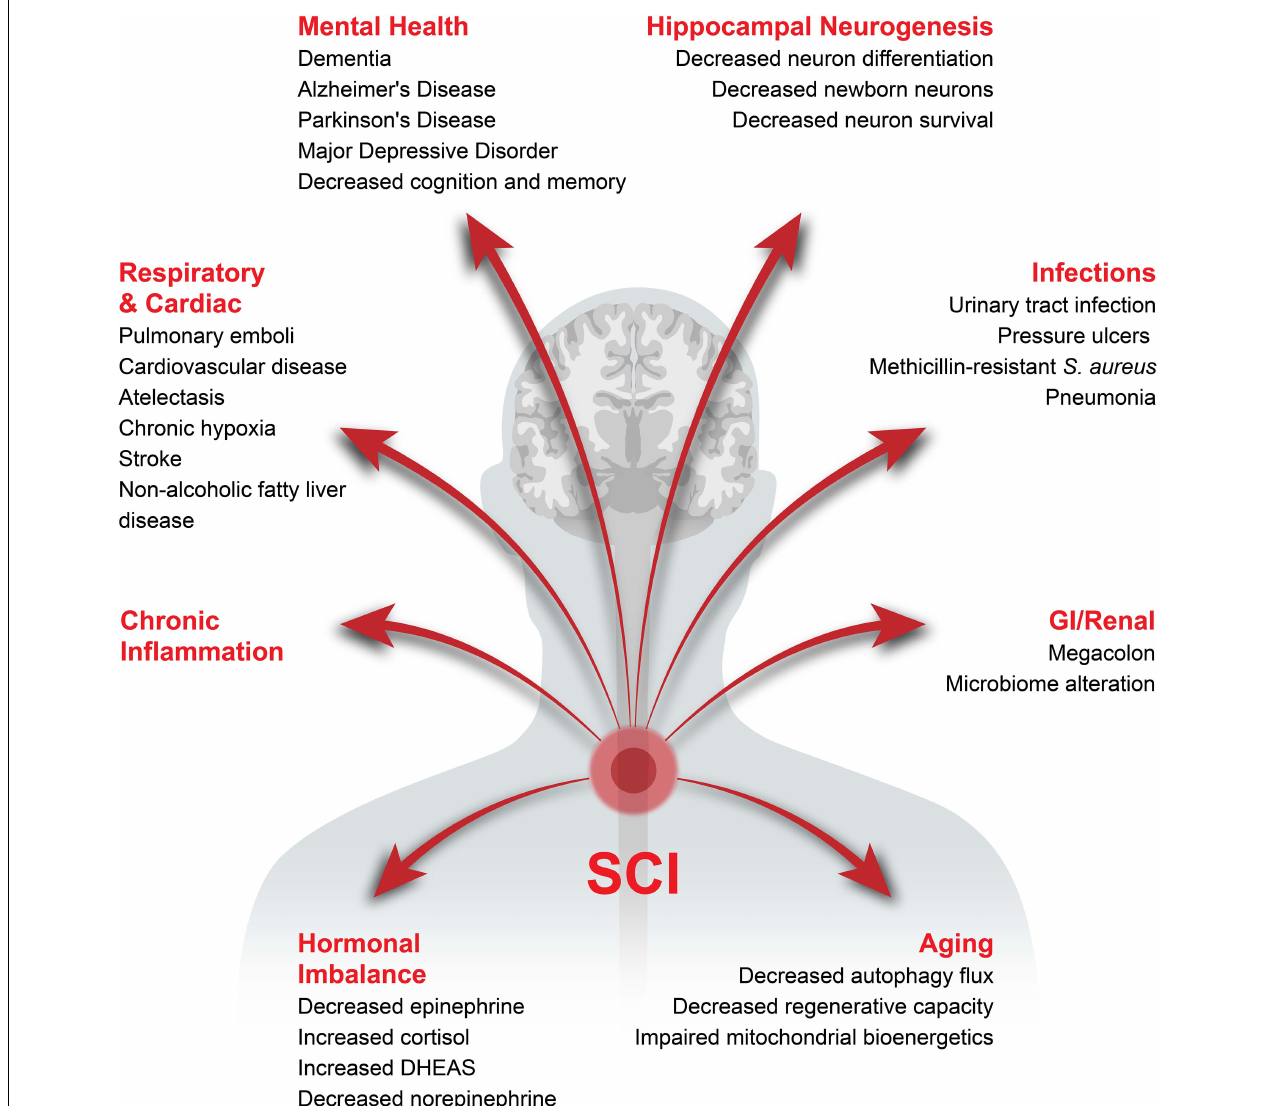
FIGURE 1 | Health complications associated with chronic SCI. The potential health complications developing after SCI have been categorized into major sections with the specific complications in the respective category listed